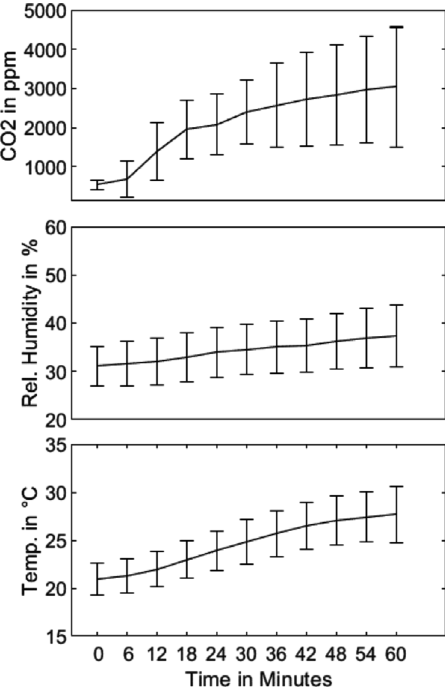
Figure 11. Mean CO 2 levels (top), relative humidity (middle); and temperature (bottom) logged over the course of the session. Error bars represent two standard